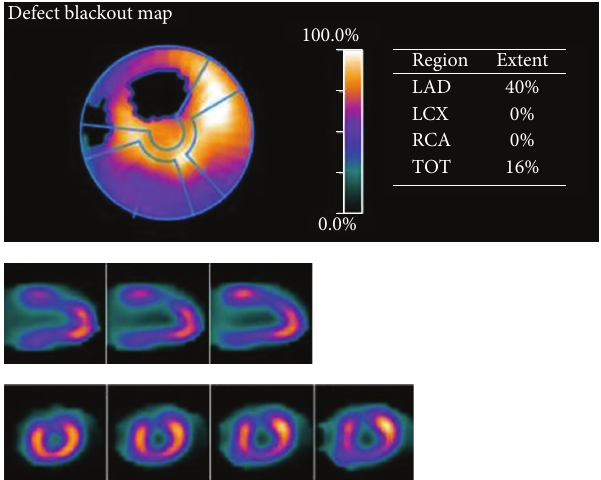
Figure 1: PET assessment. Comment: 59-year-old male with known ischaemic heart disease (requiring bypass grafting) presents for PET assessment in the context of new-onset angina. PET assessment findings of scintigraphic evidence of a reversible perfusion defect of the mid third of the anterior wall is noted. This gated data suggests a high-grade stenosis supplying this region. Noted normal leftventricularsystolicfunctionatrestwithaninduciblewallmotion abnormality and significant fall in LVEF with pharmacological